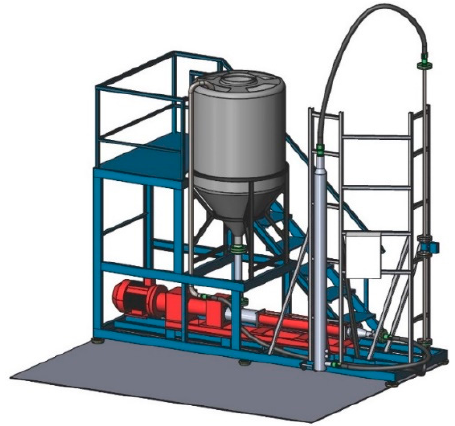
Figure A2. Hydraulic flow loop.